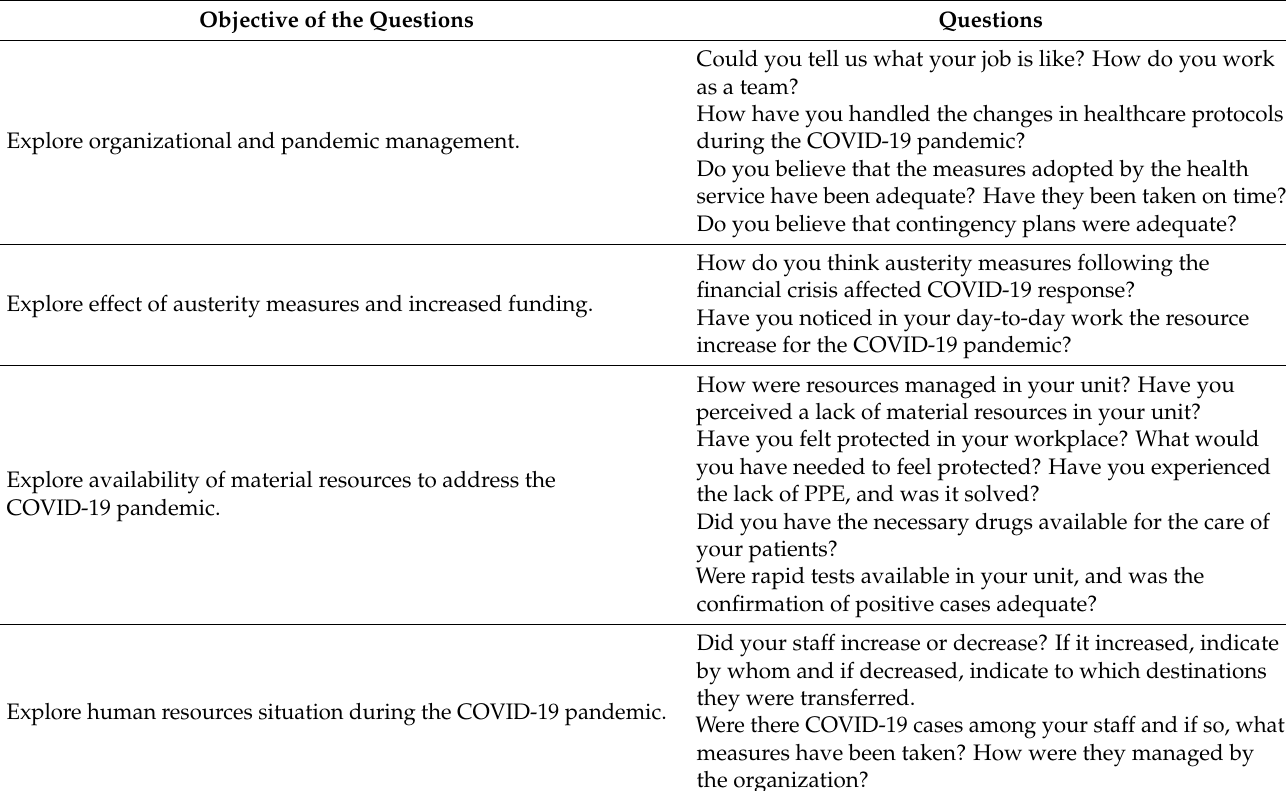
Table 2. Semi-structured interview